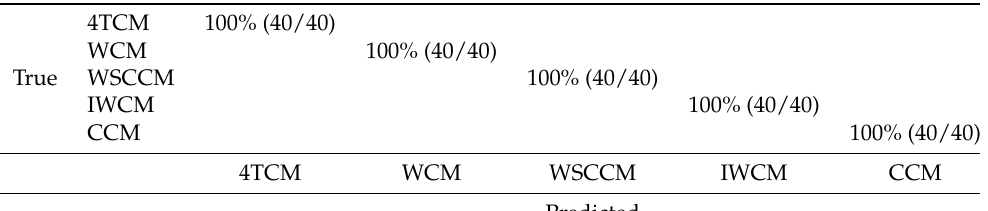
Table 16. Confusion matrix showing the performance after a “Hyperphysical Augmentation” of limited dataset size. The reached result: 100%